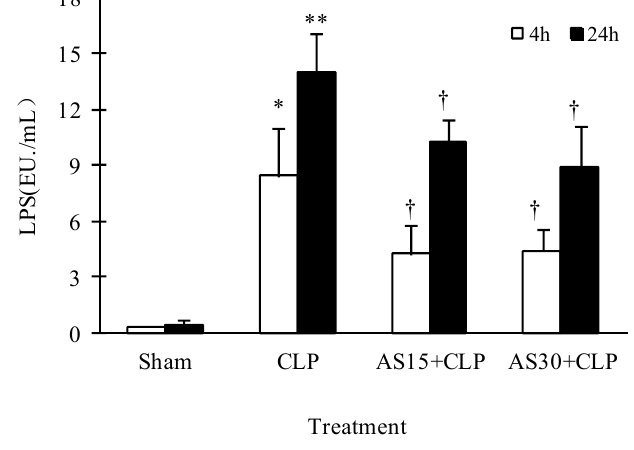
Figure 3. Effect of AS on serum LPS level of CLP models. Thirty-two mice were randomly divided into four groups ( n = 8). AS was repeatedly administered at 0 and 4 h after CLP operation. At 4 and 24 h after operation, four mice from each group were sacrificed, respectively. Sera were separated from the mice by centrifugation at 3500× g for 20 min and stored at − 80 °C for subsequent assay. The serum LPS level was assayed using limulus amebocyte lysate (LAL) test. * p < 0.05, ** p < 0.01 as compared to Sham group; † p < 0.05 as compared to CLP group. Other details are as described under Materials and Methods.